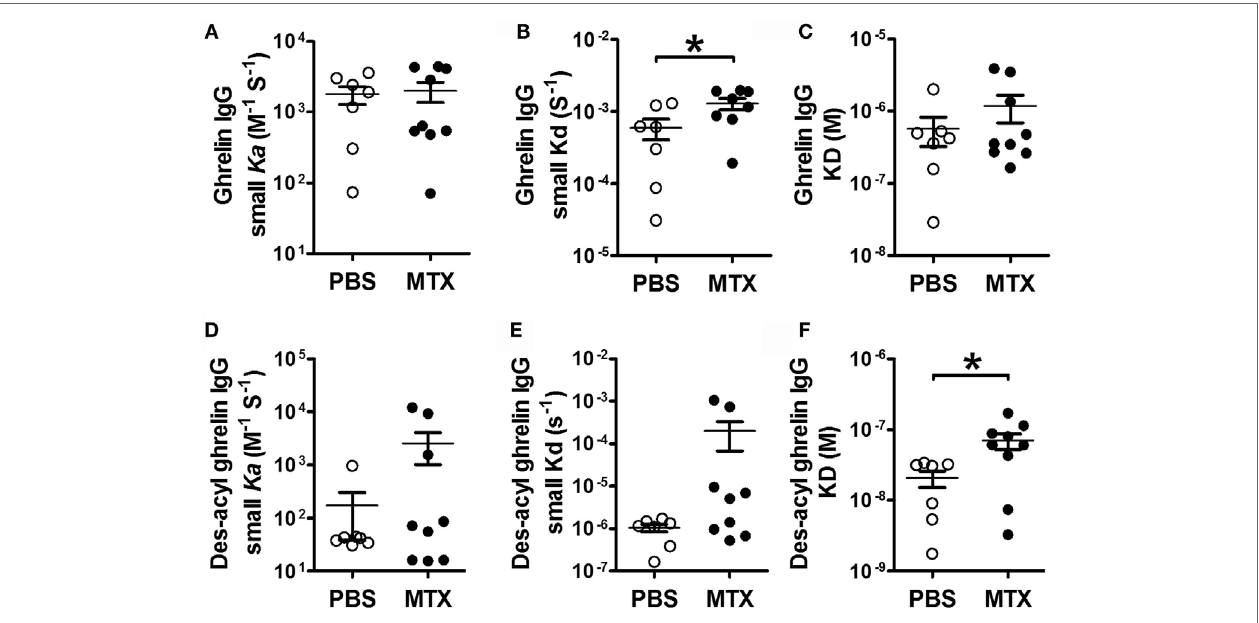
FigUre 5 | sPr affinity kinetics analysis of ghrelin- (a–c) and des-acyl ghrelin (D–F)-reactive igg in MTX-treated ( n = 9) and PBs-treated control rats ( n = 7) . The affinity kinetic parameters are: the association rates (small ka) (a,D) , the dissociation rates (small kd) (B,e) and the dissociation equilibrium constants (KD) (c,F) . Student’s t -test (B) or Mann–Whitney test according to the KS normality tests, * p < 0.05. KS tests, (B) , p > 0.1 both and ( F) , p = 0.02 and p > 0.1 (mean ±